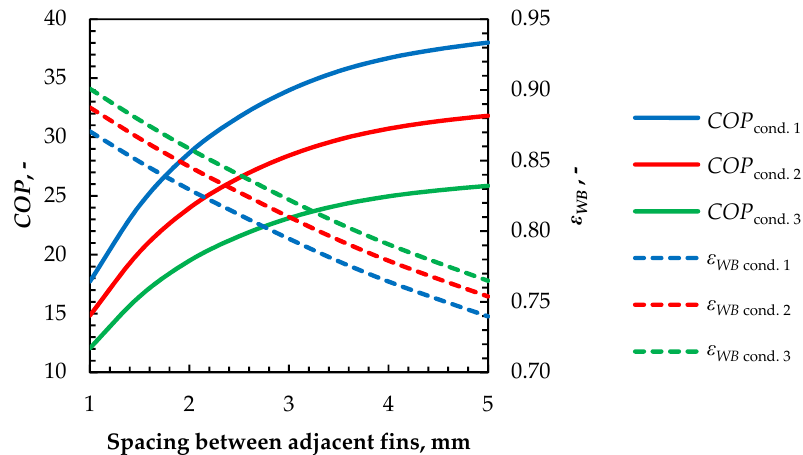
Figure 11. Impact of spacing between adjacent fins in a dry channel on the COP coefficient and wet bulb effectiveness.